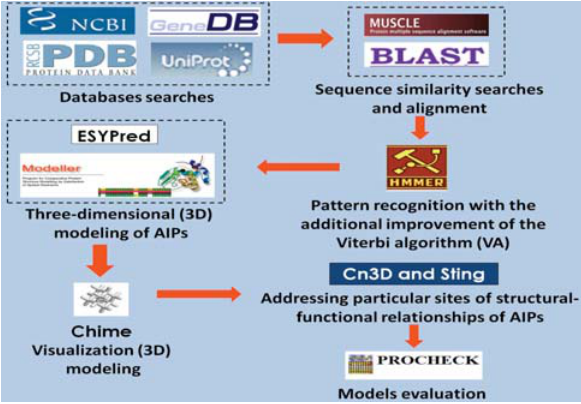
Figure 1 - Bioinformatics methods employed in this work, shown as a briefly simplified scheme of tools to illustrate a stepwise process in bio- logical information